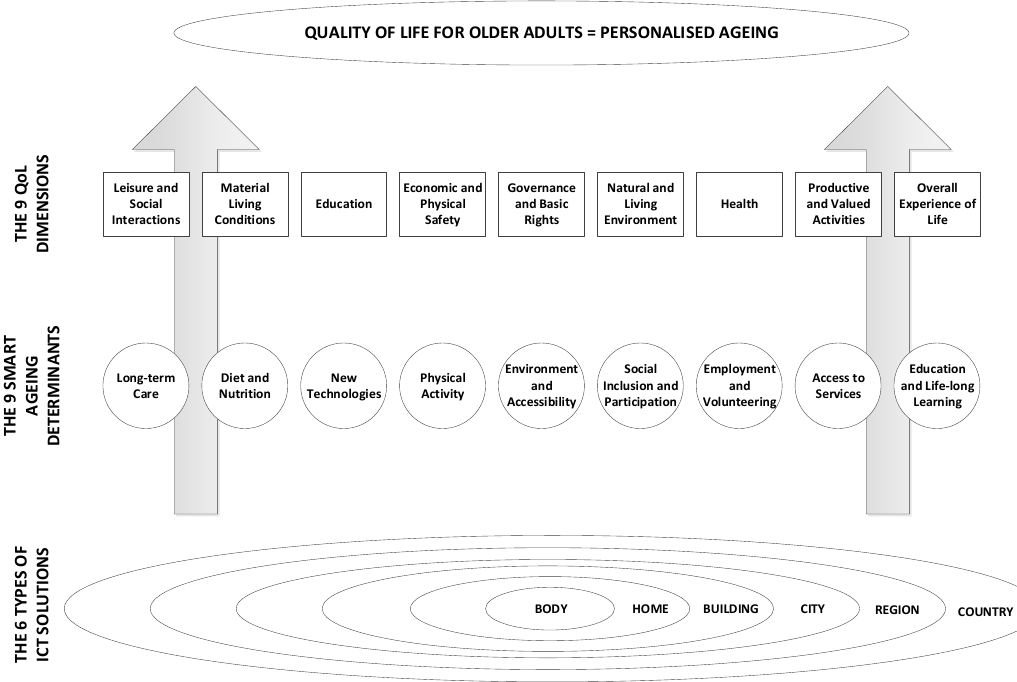
Figure 1. The framework for the Quality of Life (QoL) of older adults.